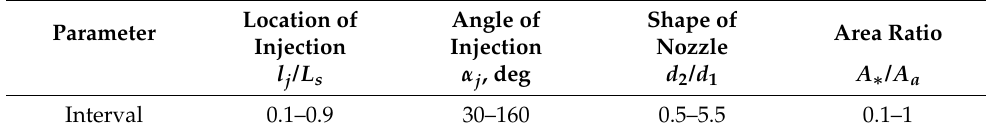
Table 1. Interval of the parameters used in the